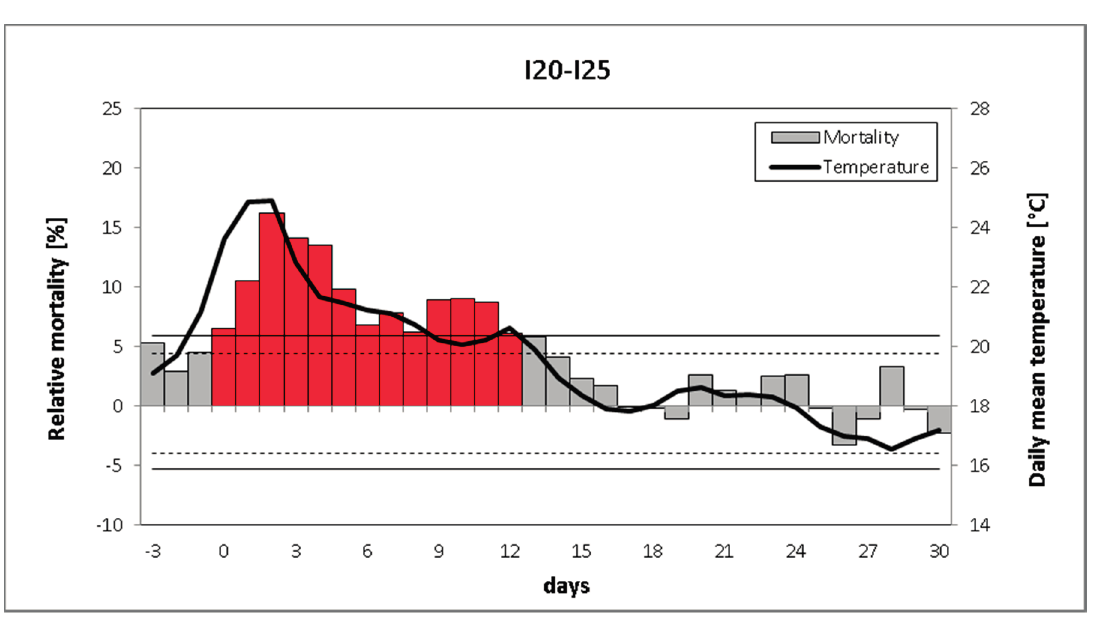
Figure 4. Mean relative deviations of IHD mortality in 2001–2010 for 34-day sequences of heat waves beginning from three days before up to 30 days after the onset of the heat waves ([20]). Solid (dashed) lines denote the 99% (95%) confidence interval obtained by the Monte Carlo method, highly significant relative deviations ( α < 0.01) are colored in